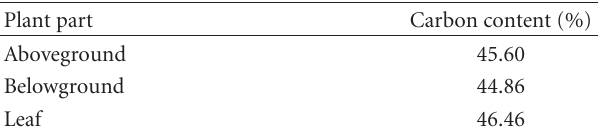
Figure 1: Linear regression of the stem diameter and biomass dry weight of the aboveground and belowground sections of Jatropha curcas . Table 2: Mean carbon content of the di ff erent parts of Jatropha curcas .